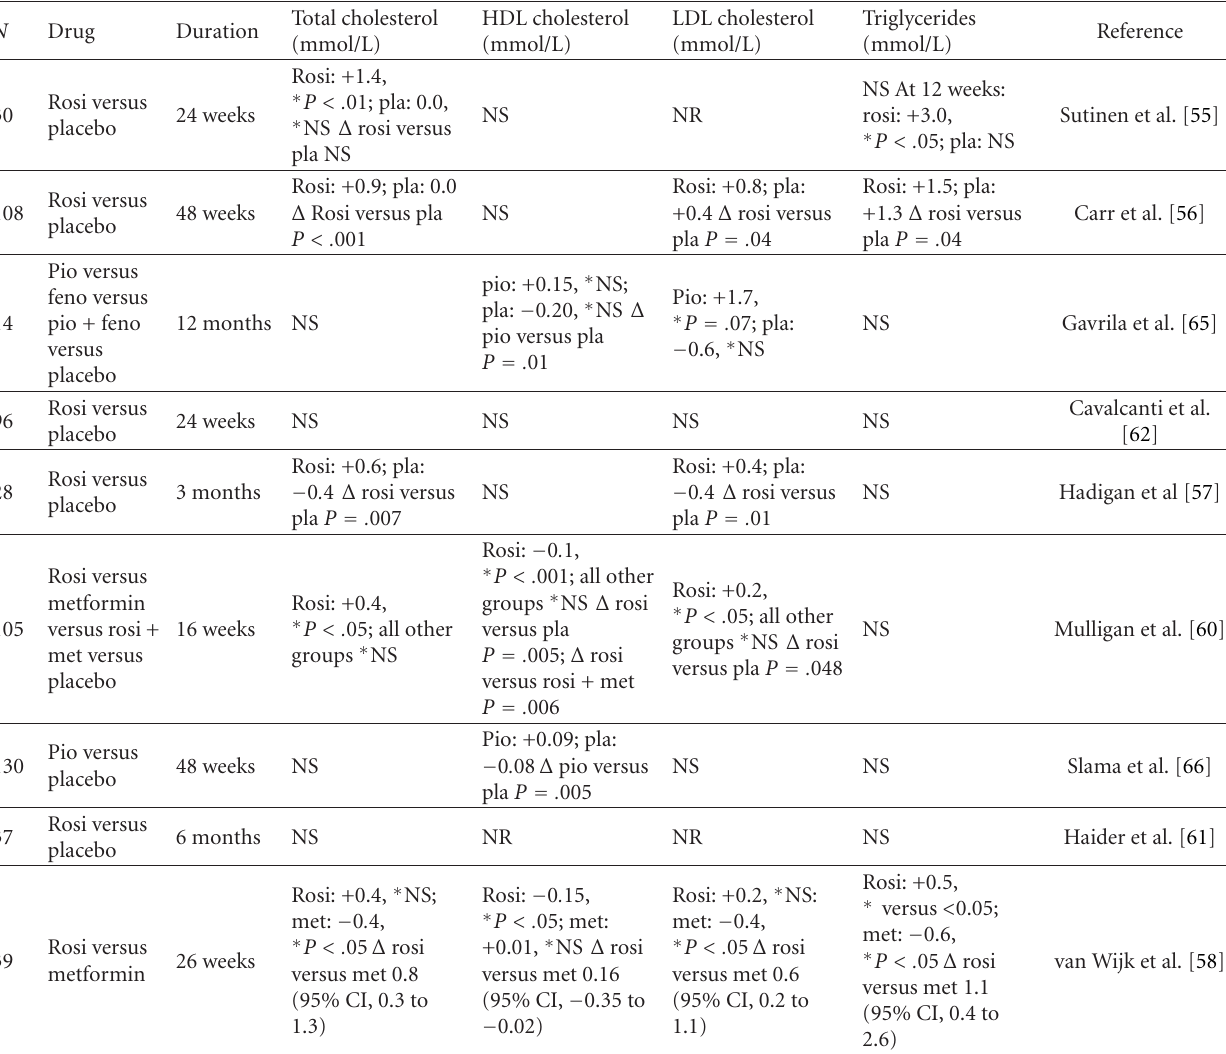
Table 5: The e ff ects of thiazolidinediones on blood lipids in comparative studies with HIV infected, HAART-treated patients. HDL =